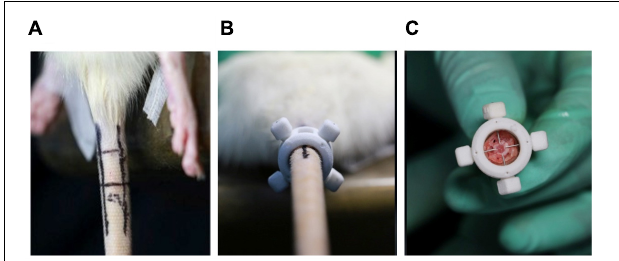
FIGURE 1 | (A) Under digital palpation guidance, rat tail discs (Co7/8) and four main vessels were noted with a permanent marker. (B) The annulus needle puncture device body was attached to the rat tail, and 27G needles were used to puncture the annulus fibrosus (AF) though four localization holes. (C) During the puncture operation, 27G needles penetrate the entire layer of the AF without directly destroying the nucleus